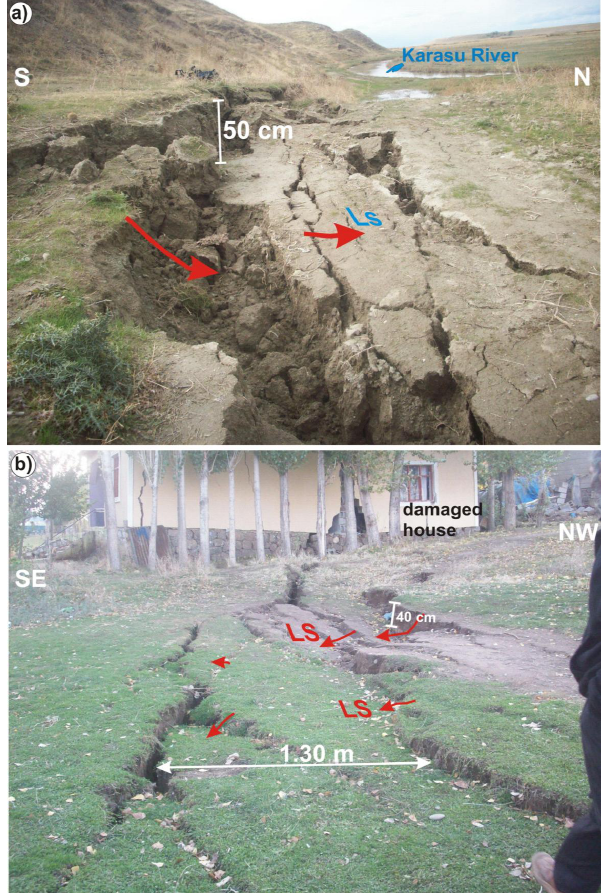
Figure 12. (a) Liquefaction related settlement occurred under a house at Çelebibağı, Erçiş (b) 3 Fig. 12. (a) Liquefaction-related settlement that occurred under a Liquefaction related settlement at the mid-part of the Erciş Basin (CGE, 2011). 4 house at C¸elebiba˘gı, Erc¸is¸ and (b) liquefaction-related settlement at the mid-part of the Ercis¸ Basin (CGE,